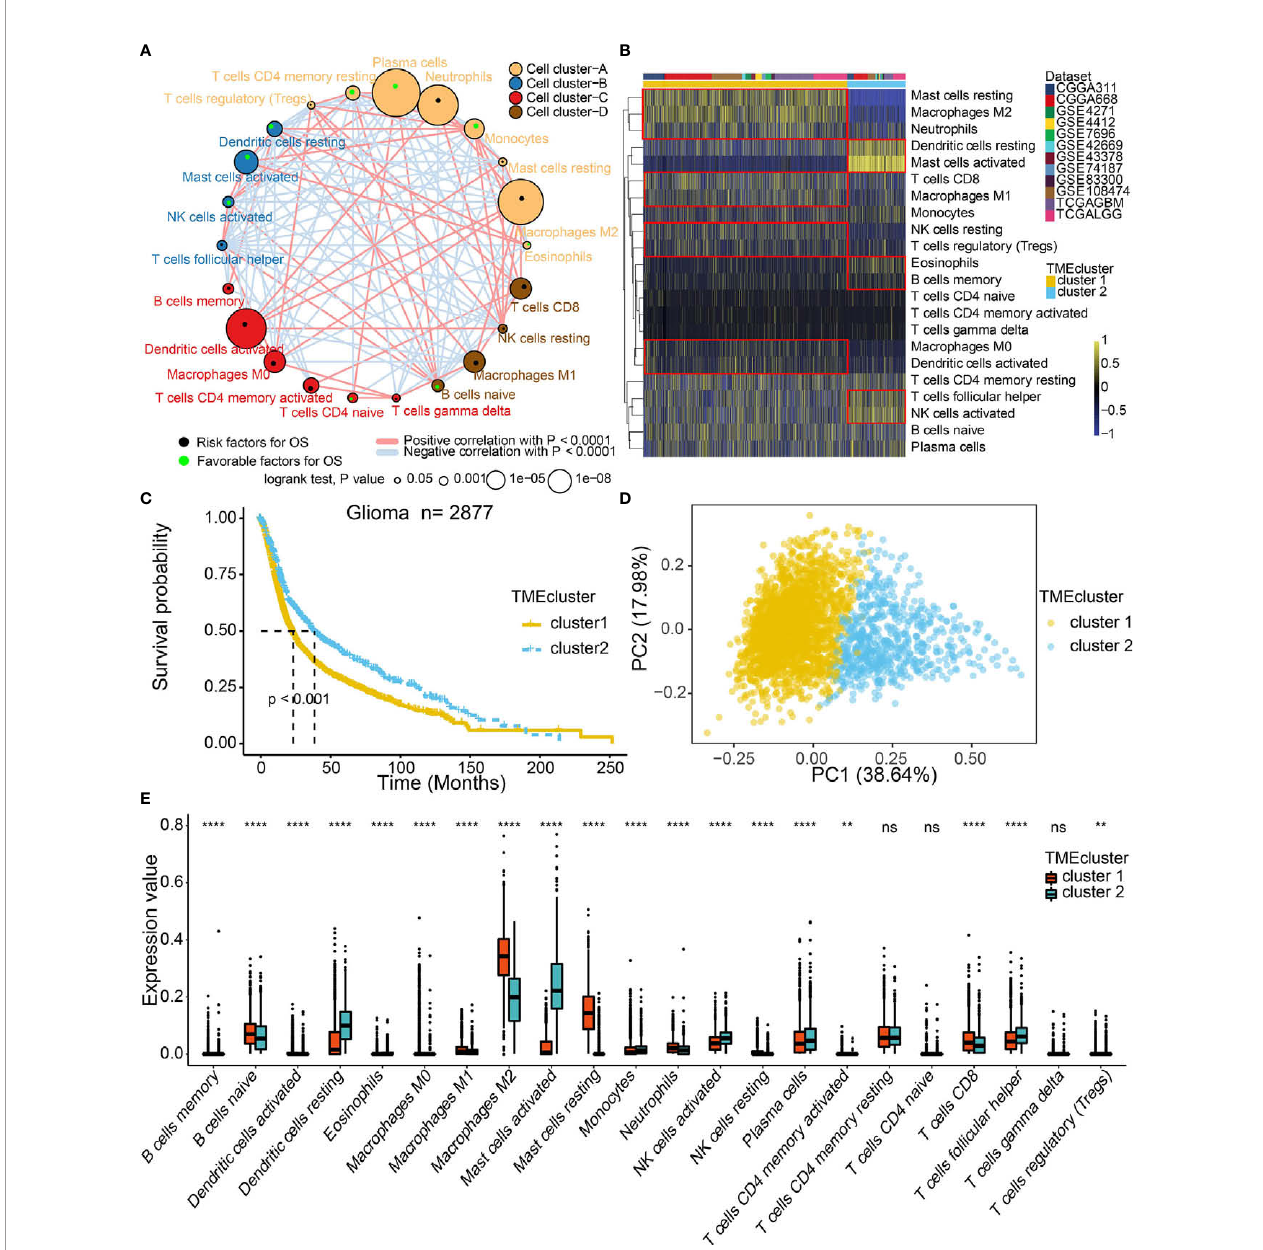
FIGURE 2 | TME landscape in gliomas and characteristics of TME subtypes in the meta-cohort. (A) Cellular interaction of the TME cell types. (B) Unsupervised clustering of TME cells for 2877 patients in the meta-cohort. (C) Kaplan – Meier curves for two TME groups of 2877 patients in the meta-cohort. Log-rank test, P < 0.001. (D) PCA separated the two TME clusters. (E) Fraction of TME cells in two TME clusters. The scattered dots represent TME cell expression values within each group. NS, Not Statistically Signi fi cant; **P < 0.01; ****P <